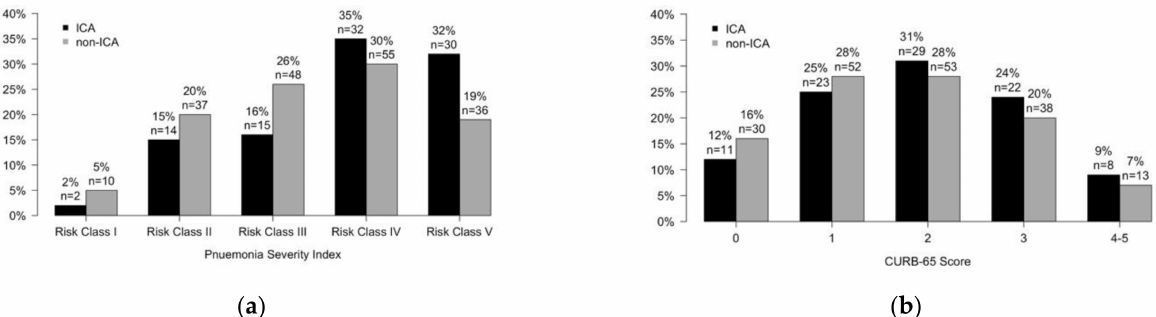
Figure 2. Distribution of severity scores by immunocompromised adults (ICA) and non-immunocompromised adults (non-ICA). Black bars represent ICA, and grey bars represent non-ICA. ( a ) Distribution of Pneumonia Severity Index (PSI) risk classes; ( b ) Distribution of CURB-65